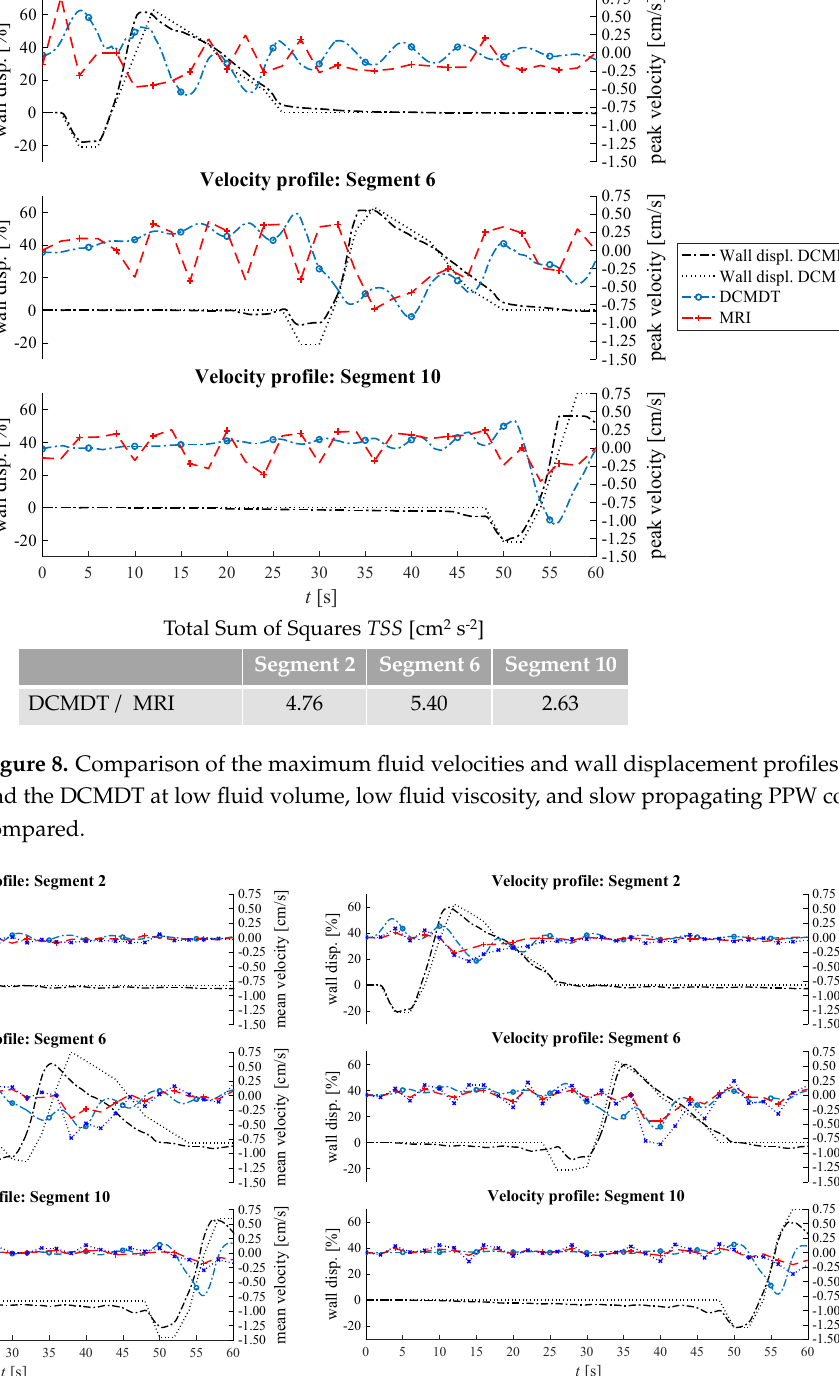
Figure 9. Comparison of the fluid velocities and wall displacement profiles of the DCM and the computational model at high fluid volume and slow propagating PPW. In ( a ) the mean fluid velocities at low fluid viscosity and in ( b ) the mean fluid velocities at high fluid viscosity are compared. When volume was increased to 80%, TSS values were <1.4 with no significant devia- tions between the experimental and computational data. This shows that the simulation is robust at the elevated volume when the slower PPW is applied. At this stage, a limita- tion of the DCM and its DT is that the ‘neutral’ volume of the lumen is fixed, so when varying the fill volume of fluid inside the lumen below 100%, an air space is present at the top of the lumen. In vivo, the capacity of the ascending colon adapts according to the volume of its contents; the walls of the colon reduce their tone and encase the contents fully, leaving no air gap (unless gas is present as a product of microbial activity). How- ever, the focus of this paper is to demonstrate that the digital twin can reproduce flows inside the DCM under different luminal conditions. Future in silico models of the human ascending colon could better represent the in vivo situation by incorporating this mor- phological response to the volume of the contents to understand how this may affect the flow of the contents. The fluid volume was then reduced back to 60% and the faster PPW was applied (Figure 10). A faster PPW involved a faster occlusion rate which caused greater mean fluid velocities compared to the slower PPW seen in Figure 7.